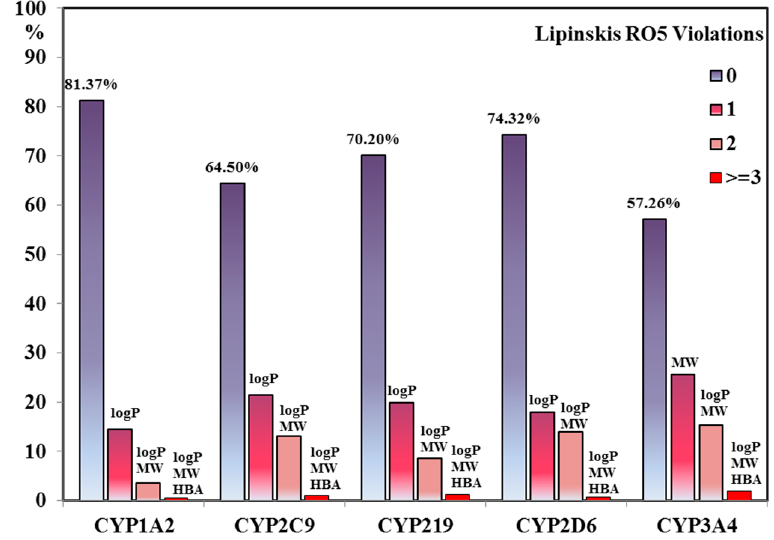
Figure 6. The bar chart distribution showing the number of Lipinski’s violations (RO5) against CYP inhibitor datasets. The most commonly violated RO5 descriptor pairs for each CYP subtype including logP, MW and HBA have also been labelled. For each data set bars are color-coded according to the number of RO5 violations, where 0 indicates no violation and 1,2 and ≥ 3 show one, two and three or more RO5 violations, respectively.